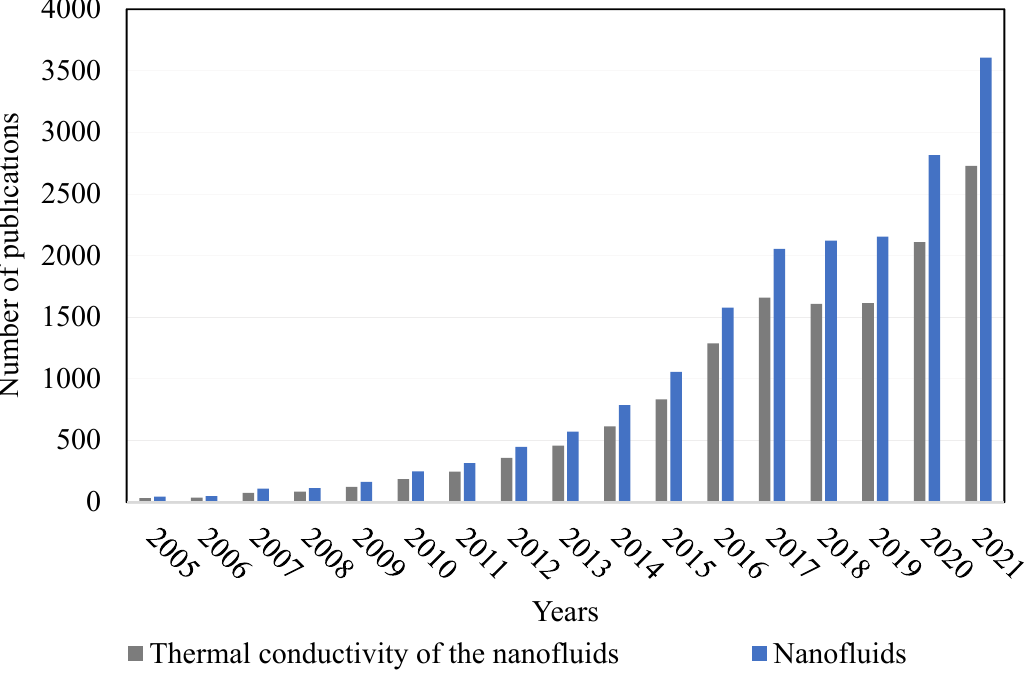
Figure 1. Number of scientific articles presented in the ScienceDirect database from the year 2005 up to 2021.